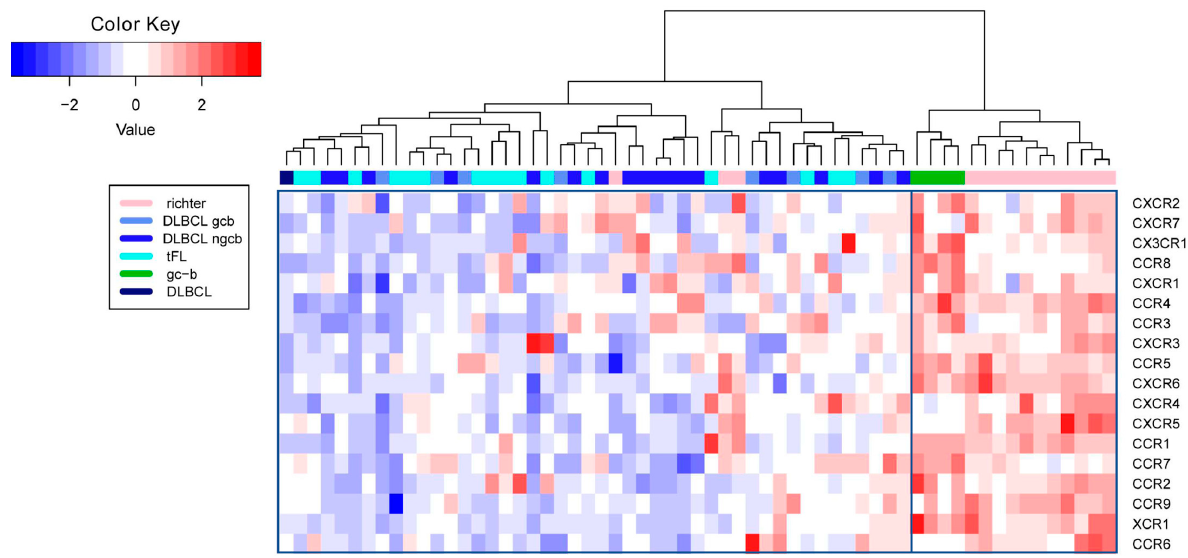
Figure 3. Heatmap based on Δ CT-values of the 18 analyzed chemokine receptors for 4 GC-B, 8 GCB-DLCBL, 18 NGCB-DLBCL, 16 tFL, and 14 RS samples, and hierarchical clustering of these analyzed samples. The color at the top designates whether the sample is a GC-B (green), RS (pink), GCB-DLBCL (light blue), NGCB-DLBCL (blue), tFL (bright blue), or unclassified DLBCL (dark blue) specimen. Scaled Δ CT-values are visualized in shades of blue to red (lower to higher values), with lower values representing a higher mRNA expression and higher values indicating lower mRNA expression.